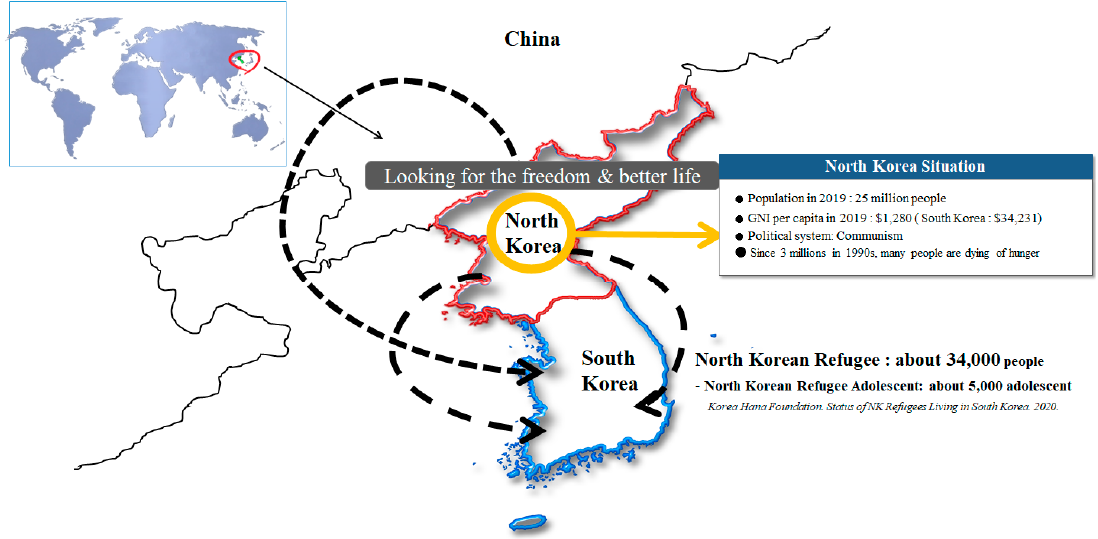
Figure 1. North Korea’s situation and the route of escape from North Korea .